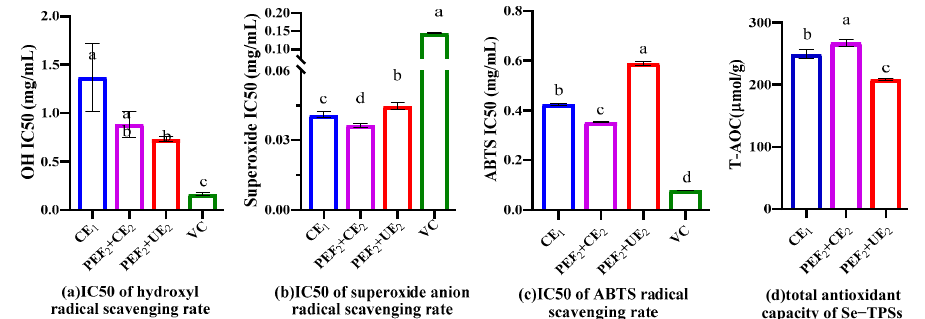
Figure 8. IC50 of hydroxyl radical scavenging rate ( a ), superoxide anion radical scavenging rate ( b ), ABTS radical scavenging rate ( c ), and total antioxidant capacity of Se − TPSs (T-AOC) ( d ). Differ- ent letters above the columns represent siginificantly different antioxidant activities ( p <